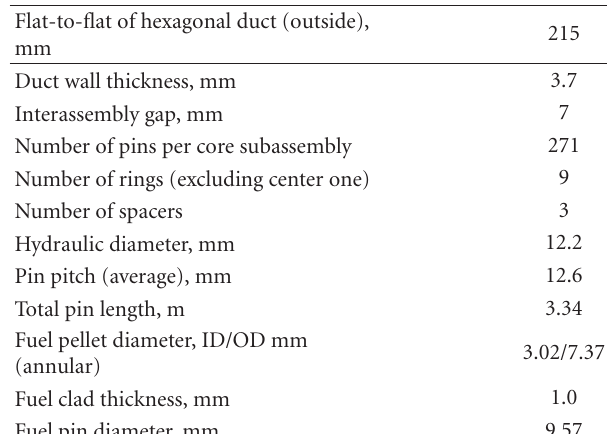
Table 3: Core parameters.